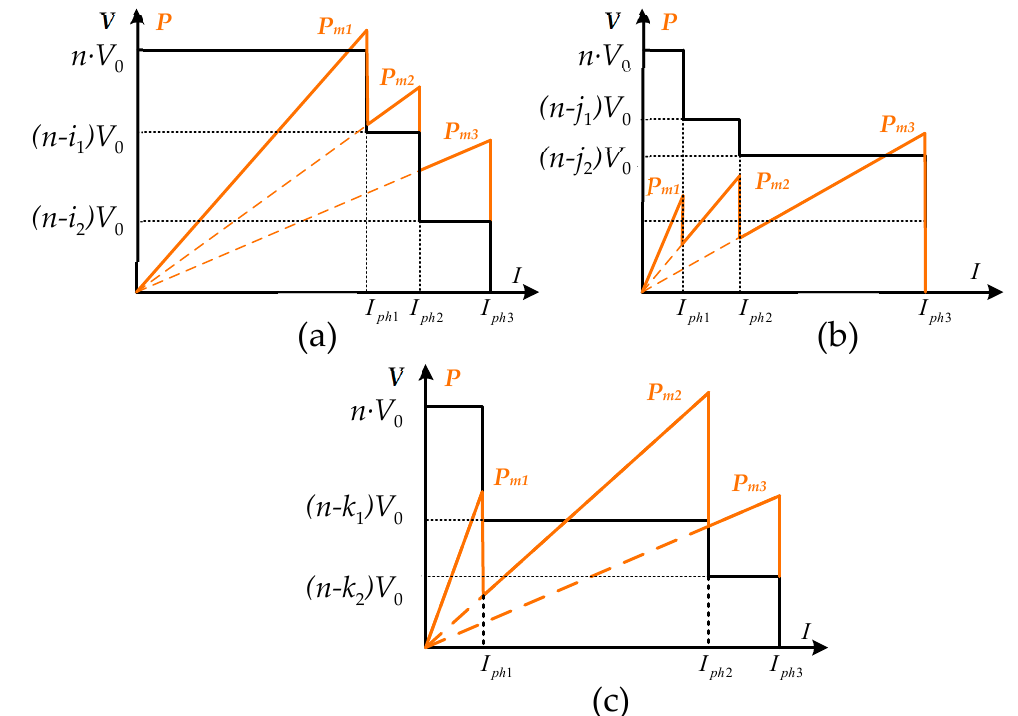
Figure 4. The V–I and P–I curves of a solar array with differently irradiated groups of modules: ( a ) the first maximum is the global one, ( b ) the third maximum is the global one, and ( c ) the second maximum is the global one.